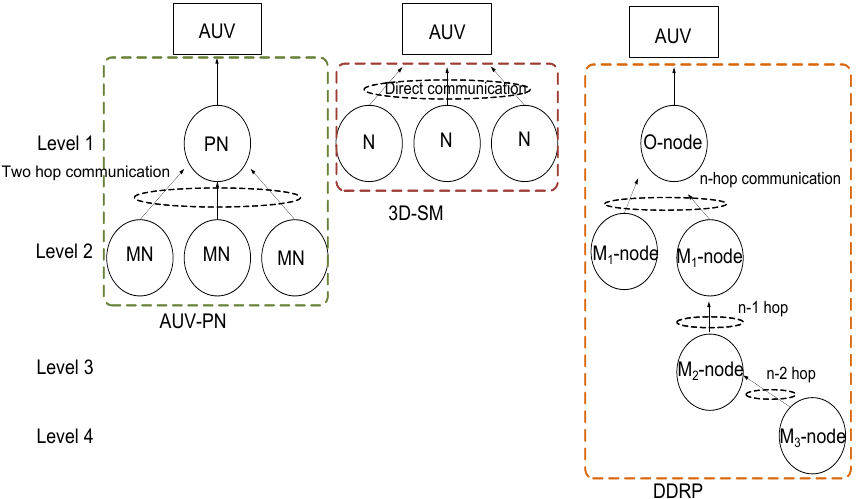
Figure 1. Comparison of the proposed and the counter schemes.